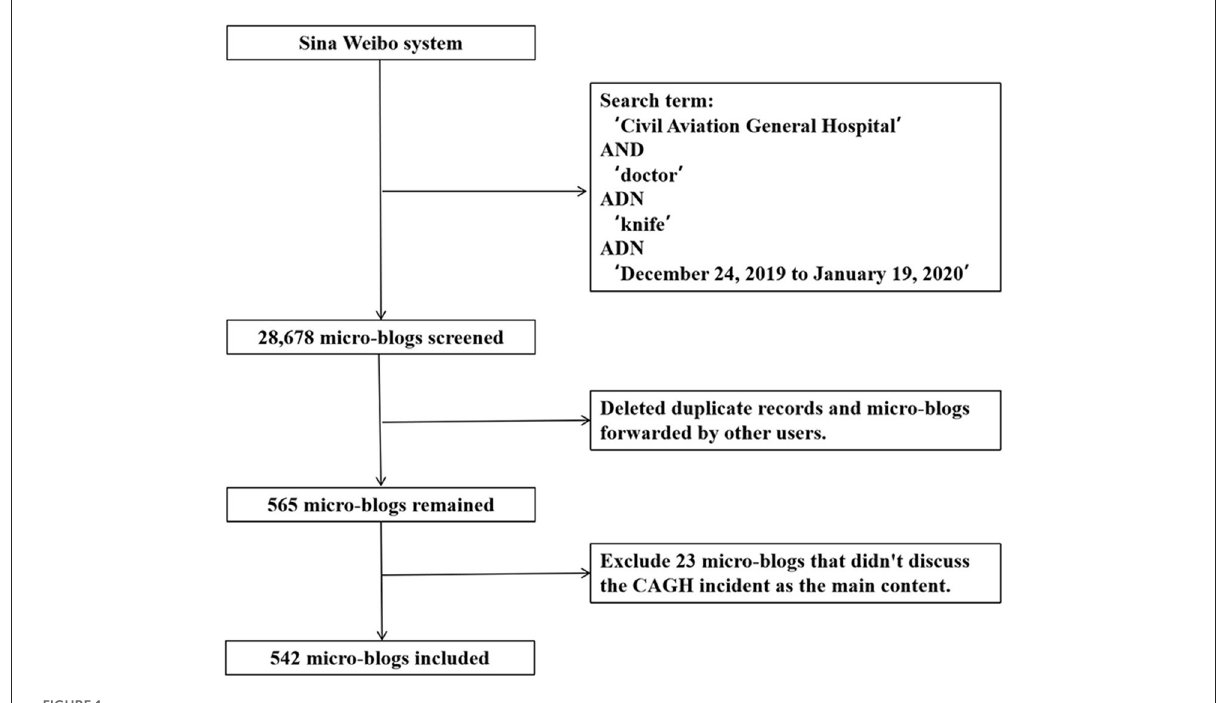
FIGURE1 Flow chart of Weibo post